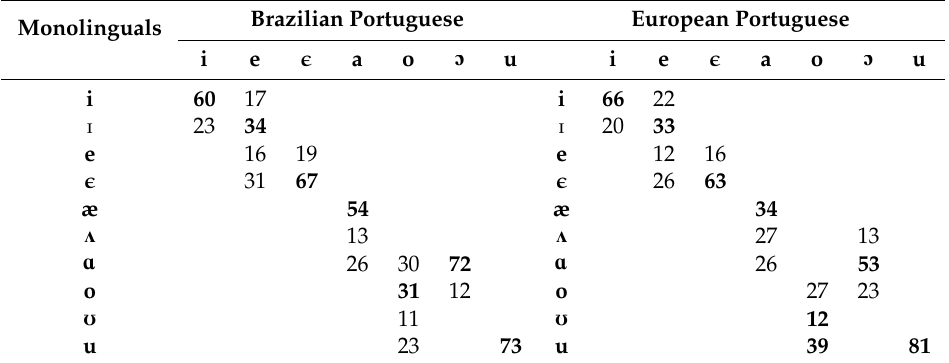
Table 2. Californian English monolingual listeners’ classification percentages for Brazilian Portuguese (BP, left) and European Portuguese (EP, right). The native vowel category with the highest classification percentage appears in bold and those percentages below chance (i.e., 10%) are not shown. Monolinguals